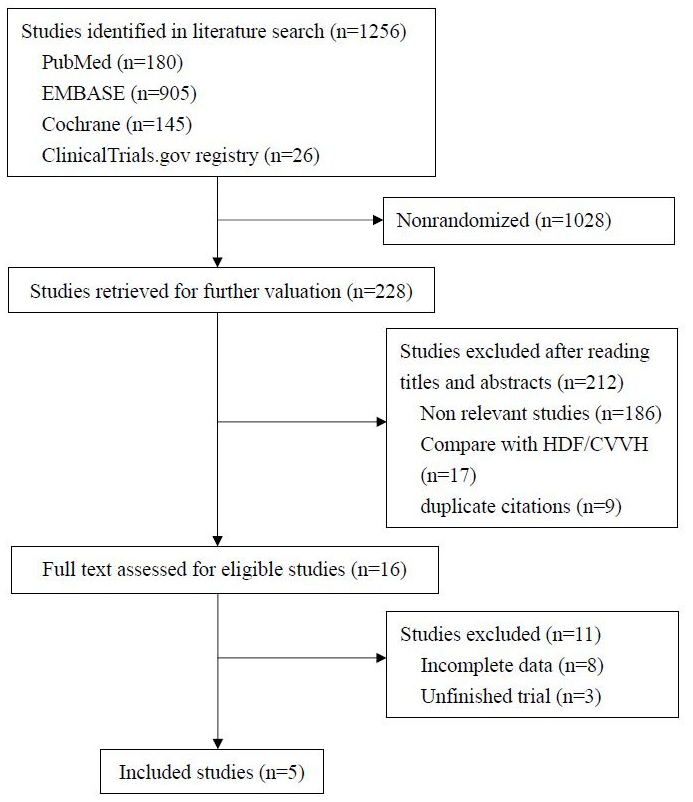
Figure 1. Flow chart for selection of studies.